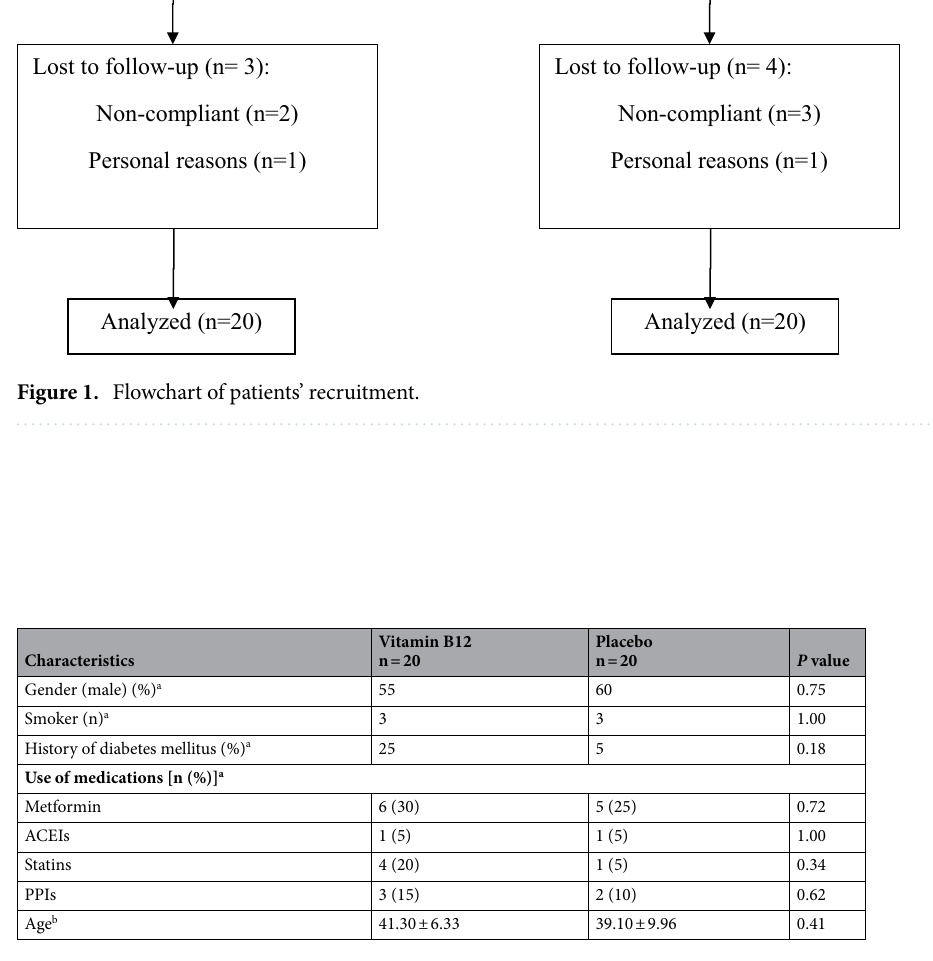
Table 1. Baseline characteristics of 40 patients with NAFLD. ACEI s angiotensin-converting enzyme inhibitors, NAFL D non alcoholic fatty liver disease, PPIs Proton-pump inhibitors. a Data is tested by chi-square test or Fisher’s exact test. b Data is expressed as mean ± standard deviation and tested by two sample